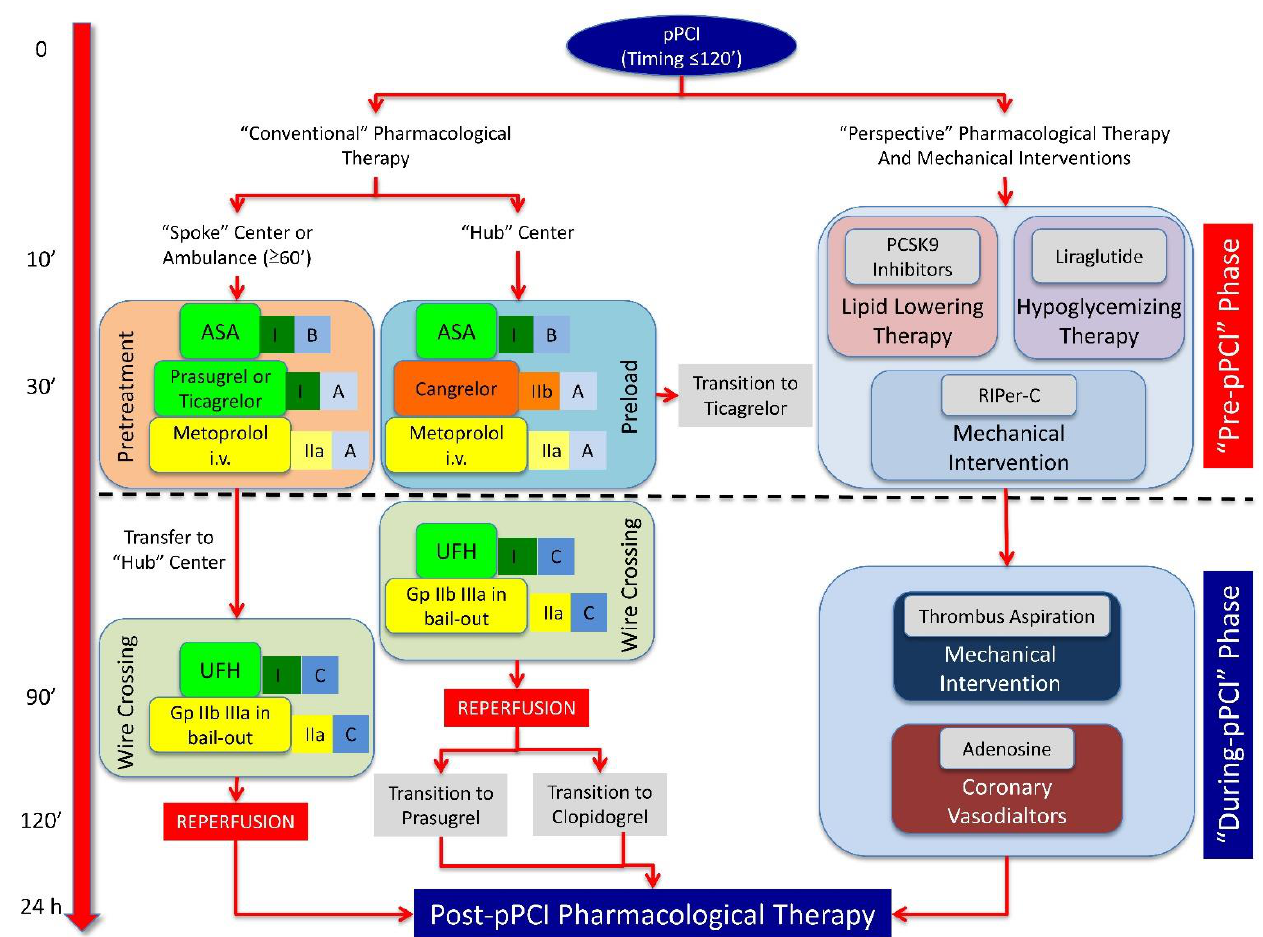
Figure 3. Scheme for a reasoned multitarget therapeutic strategy against post-STEMI LVR, in the ‘pre-PCI’ and ‘during-pPCI’ phases. On the left side of the picture, the timing of conventional pharmacological therapy for STEMI patients is described, in the ‘pre-PCI’ and ‘during-pPCI’ phases, according to the European Society of Cardiology (ESC) guidelines. Each pharmacological indication is identified with its own class of recommendation and level of evidence. On the right side of the picture, perspective pharmacological therapies and mechanical interventions in order to further improve protection against post-STEMI LVR according to precise timing are listed. PCSK9 inhibitors, liraglutide, and RIPer-C should be administered in the ‘pre-PCI’ phase, whereas thrombus aspiration (especially in patients with high glycemic values) and adenosine (in case of no-reflow phenomenon) should be used in the ‘during-pPCI’ phase. STEMI: ST elevation myocardial infarction; pPCI: primary percutaneous intervention; LVR: left ventricular remodeling; PCSK9: proprotein convertase subtilisin/kexin type 9; RIPer-C: remote ischemic perconditioning; ASA: acetylsalicylic acid; UFH: unfractioned heparin; Gp IIb IIIa: glycoprotein IIb IIIa.